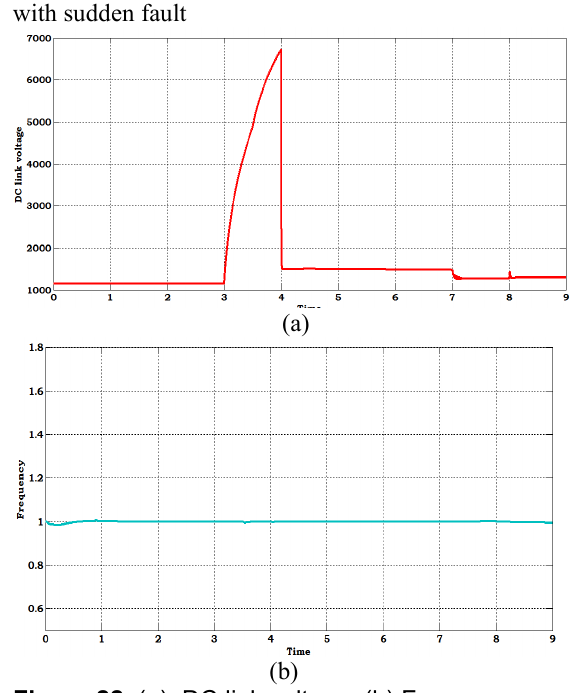
Figure 22. (a). DC link voltage, (b).Frequency (iii). Model Predictive Control Based System Test Case 1: When operating system in grid connected mode with